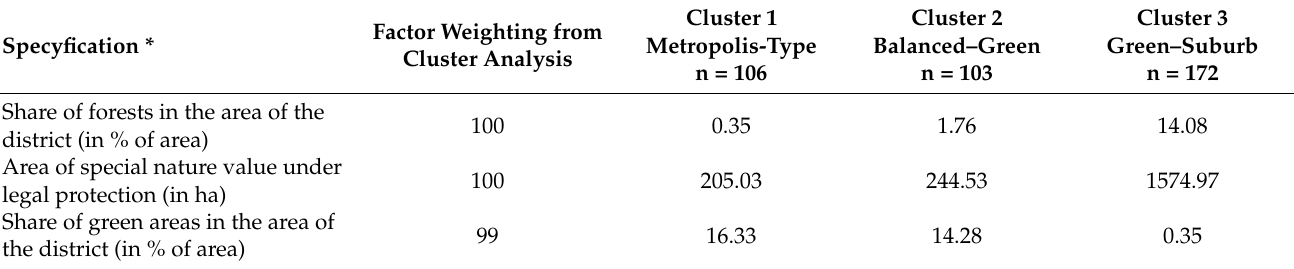
Figure 1. Cluster localization (the numbers on the map of the city of Warsaw indicate the districts whose names are given in the columns relating to the individual clusters). Table 2. Clusters